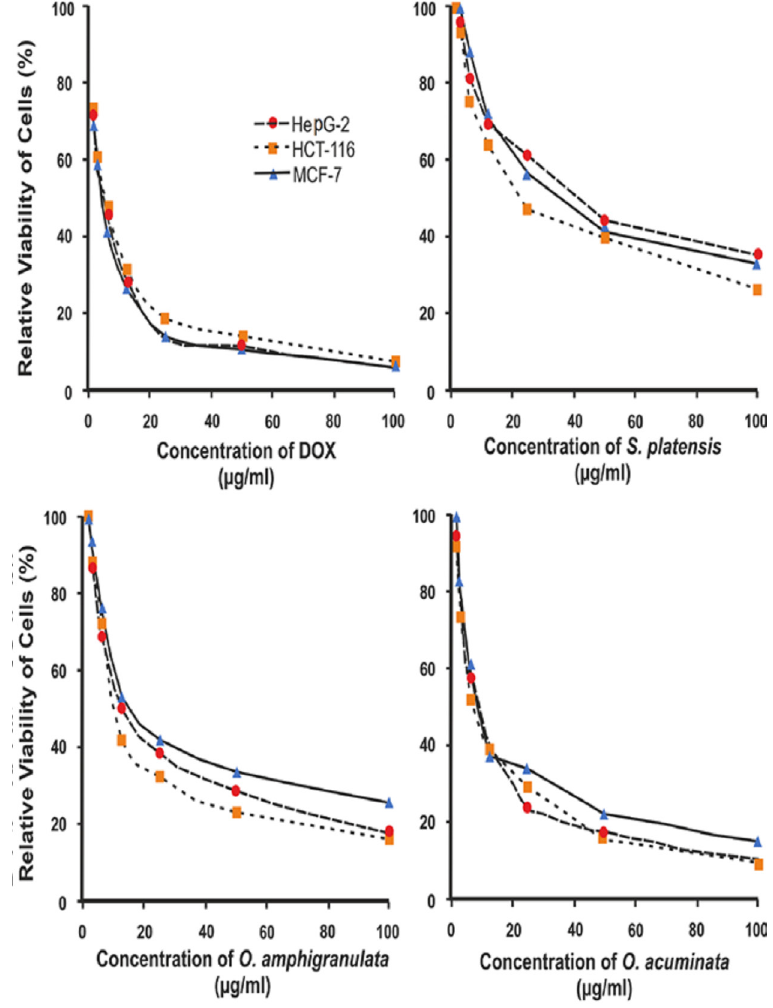
Figure 1. Cytotoxicity assay of cyanobacterial concentrations on different cell lines by MTT